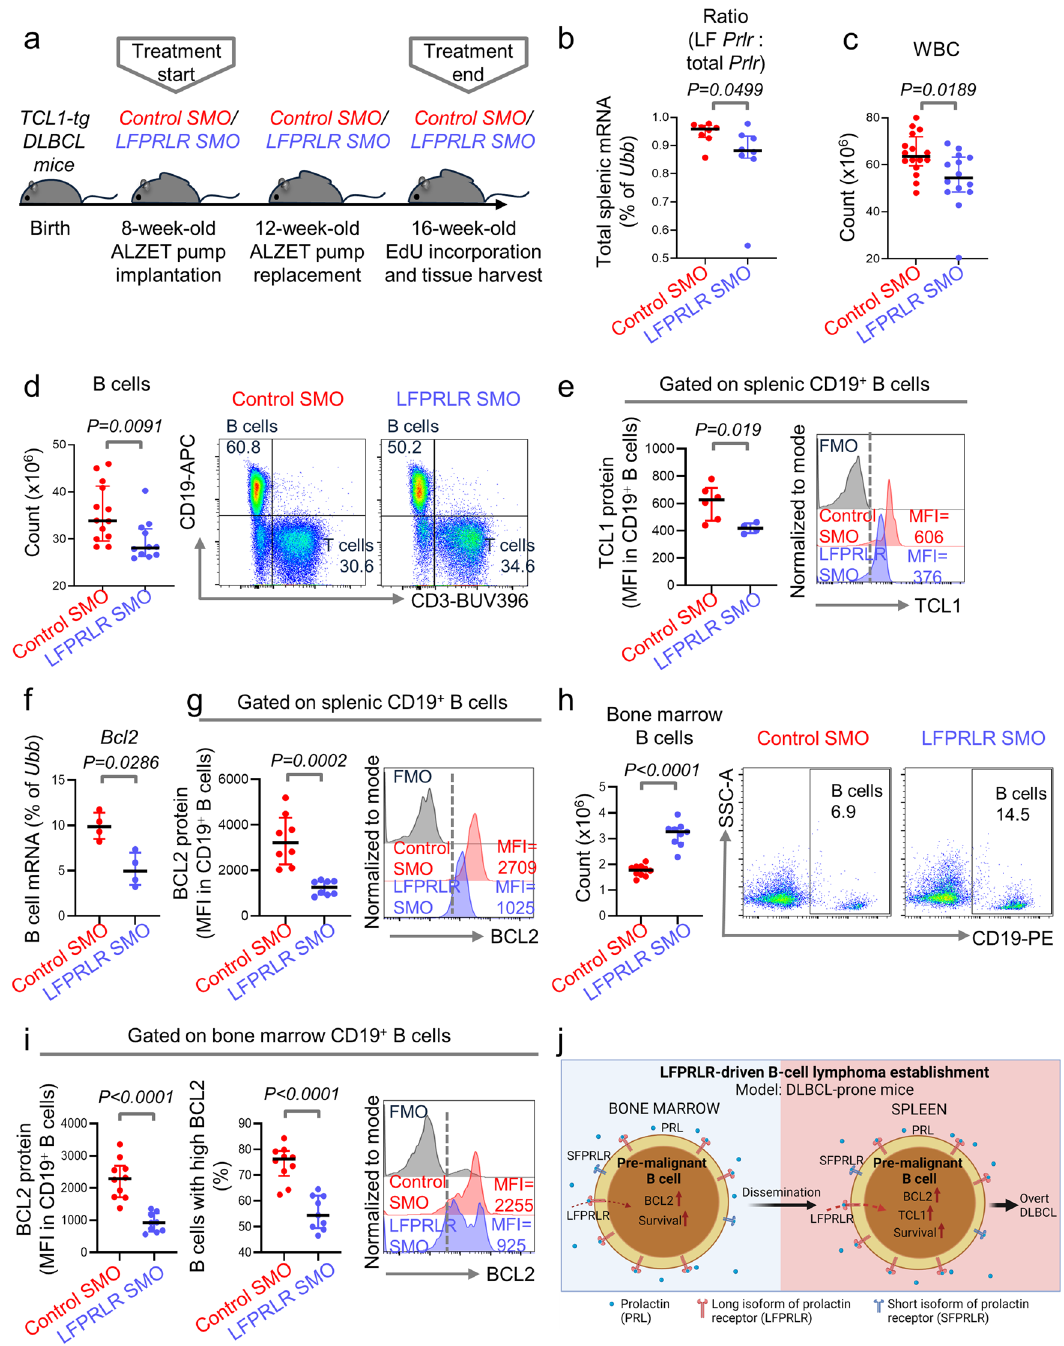
Fig. 4 Knockdown of LFPRLR in DLBCL-prone mice suppresses factors that can drive overt B-cell lymphomagenesis. a – c Experimental design ( a ), veri fi cation of LFPRLR knockdown in total splenic WBCs by qPCR ( b ), and splenic WBC counts ( c ) in TCL1-tg DLBCL-prone mice treated with control SMO [ n = 8 for ( b ) and n = 16 for ( c ), red] or LFPRLR SMO [ n = 8 for ( b ) and n = 14 for ( c ), blue]. d – i Quantitation and representative fl ow cytometry plots of CD3 − CD19 + B cells ( d , h ), splenic B cell-speci fi c expression of TCL1 ( e ), and B cell-speci fi c expression of BCL2 ( f , g , i ) in spleen and bone marrow of TCL1- tg mice treated with control SMO [ n = 14 for ( d ), n = 6 for ( e ), n = 4 for ( f ), n = 8 for ( g ) and n = 10 for ( h , i ), red] or LFPRLR SMO [ n = 12 for ( d ), n = 4 for ( e ), n = 4 for ( f ), n = 8 for ( g ) and n = 9 for ( h , i ), blue]. One representative histogram from each group for measurement of TCL1 protein in spleen and BCL2 protein in spleen and bone marrow is shown. j PRL-LFPRLR signaling upregulates BCL2 and increases survival of pre-malignant B cells, thereby enhancing the risk of establishment of overt B-cell malignancies. Graphs show median ± interquartile range. Each dot in qPCR analyses of transcripts corresponds to the mean expression of that gene in pooled samples from 3 mice that were run in 3 technical replicates. Ubb was used as the house keeping gene in qPCR. Exact p -values were calculated using the Mann – Whitney U test. ns non-signi fi cant, FMO fl uorescence minus one control, MFI median fl uorescence intensity. j was created with BioRender.com.